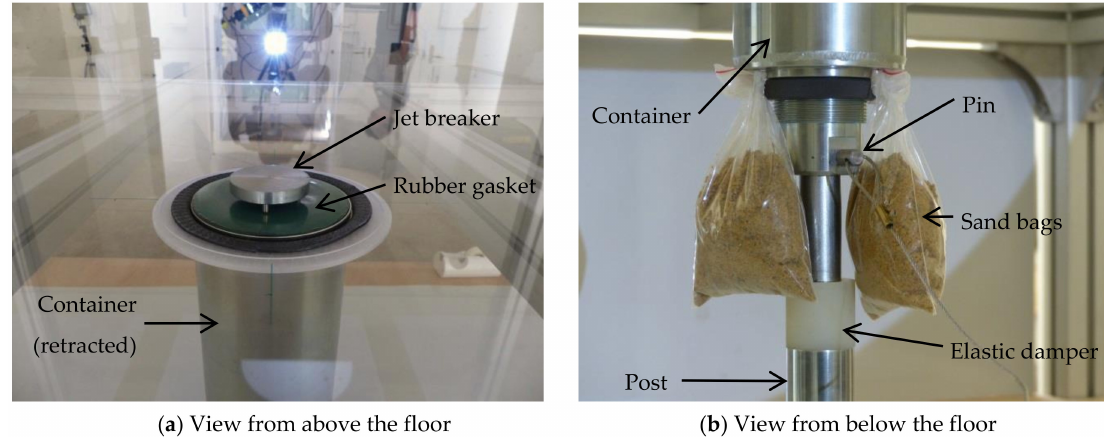
Figure 2. Detailed view of the retractable, metallic, cylindrical container used to contain the dense gas at the initial state.